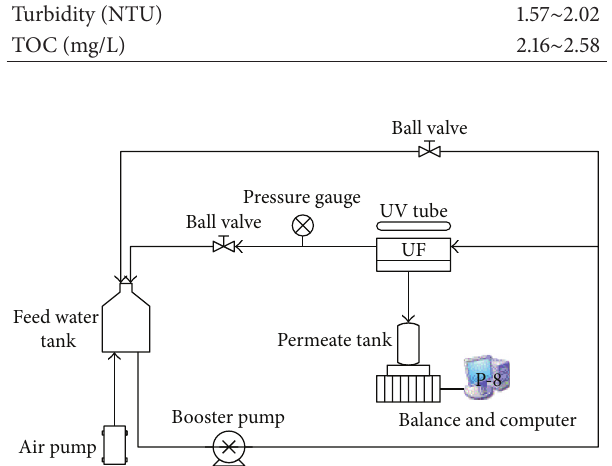
Figure 1: Diagram of the UF and UV/TiO 2